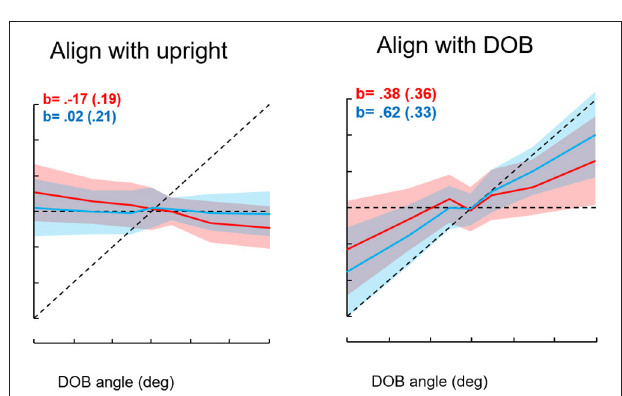
FIGURE 10 | Results for the conditions “align with the upright” and “align with the direction of balance.” Seven directions of balance (DOB) were presented twice for each instruction type for 16 subjects. The DOBs were − 30 ◦ , − 15 ◦ , − 5 ◦ , 0 ◦ , + 5 ◦ , + 15 ◦ , and + 30 ◦ . Red entries represent achieved angles, blue represents indicated angles. The shading indicates standard deviations. The b entries represent slopes of MARS angles in degrees vs. DOB angles. The sign convention is minus entries represent rightward tilts of the subject and DOB, positive is leftward tilts. The intersection of the dotted horizontal and diagonal lines corresponds to 0 ◦ , the direction of